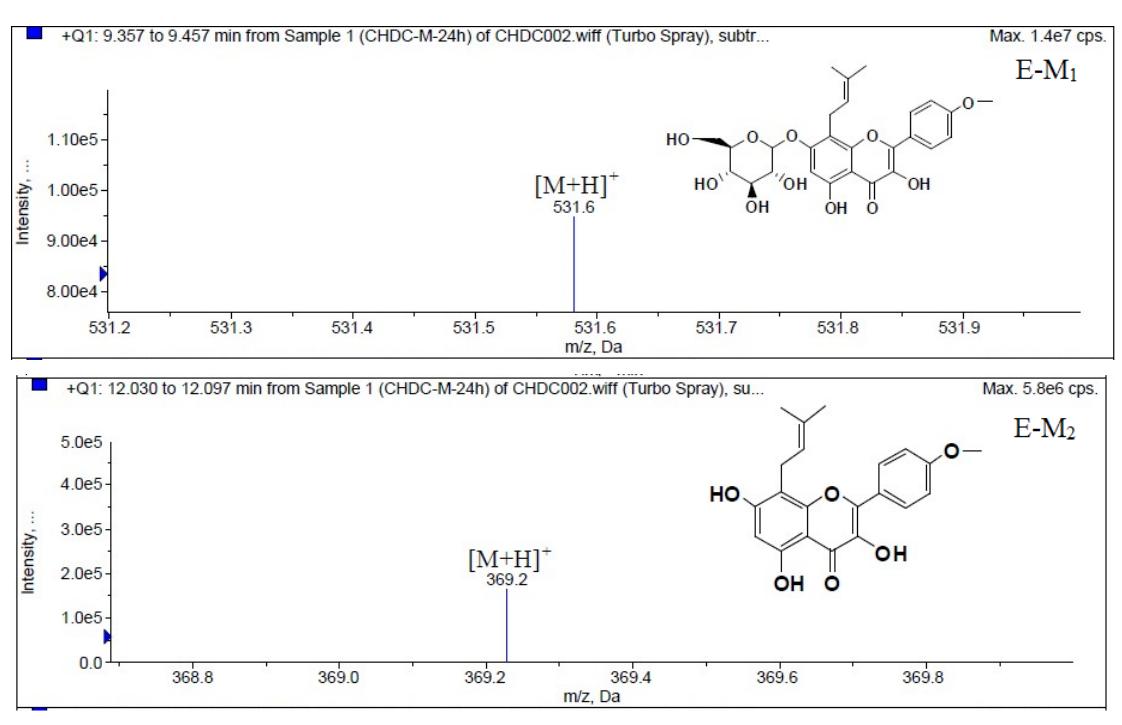
Figure 9. Mass spectra of metabolite of epimedin C. E for metabolites in intestinal enzyme; F for metabolites in intestinal